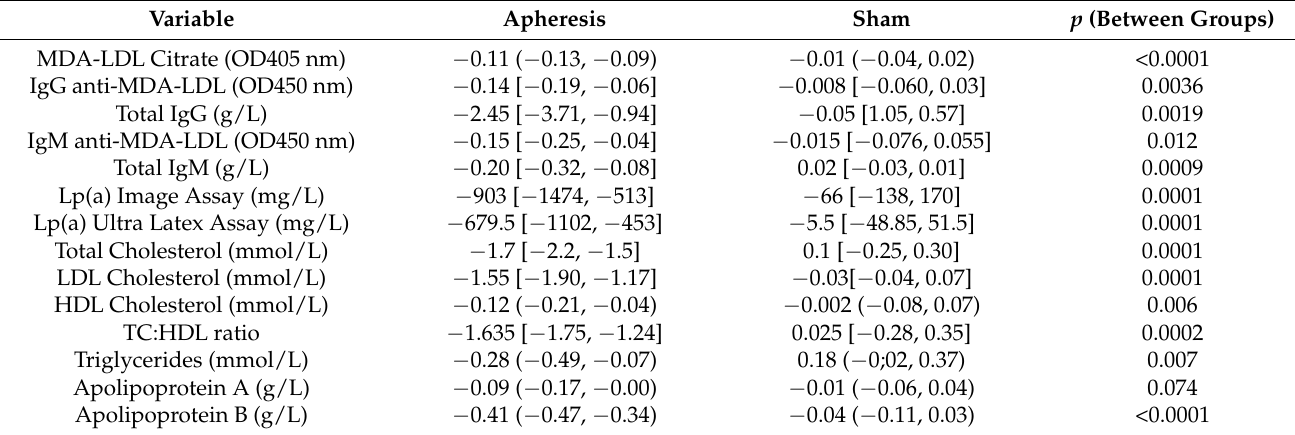
Table 2. Change in MDA-LDL and its associated antibodies and lipid parameters during apheresis and sham shown as mean (lower 95% CI, upper 95% CI) or median IQR.